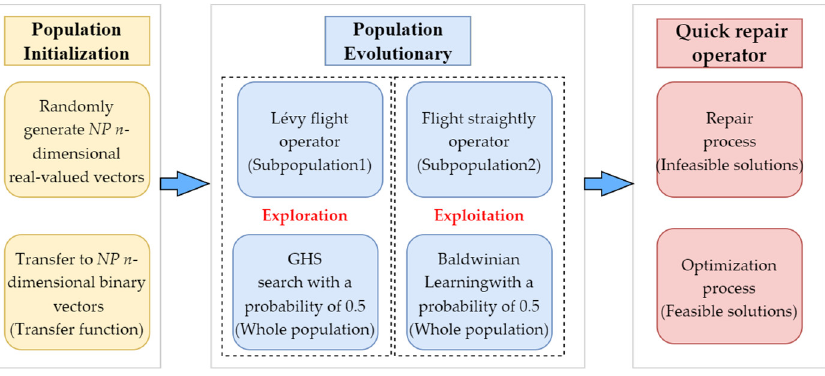
Figure 1. The framework of HLMS for MKP